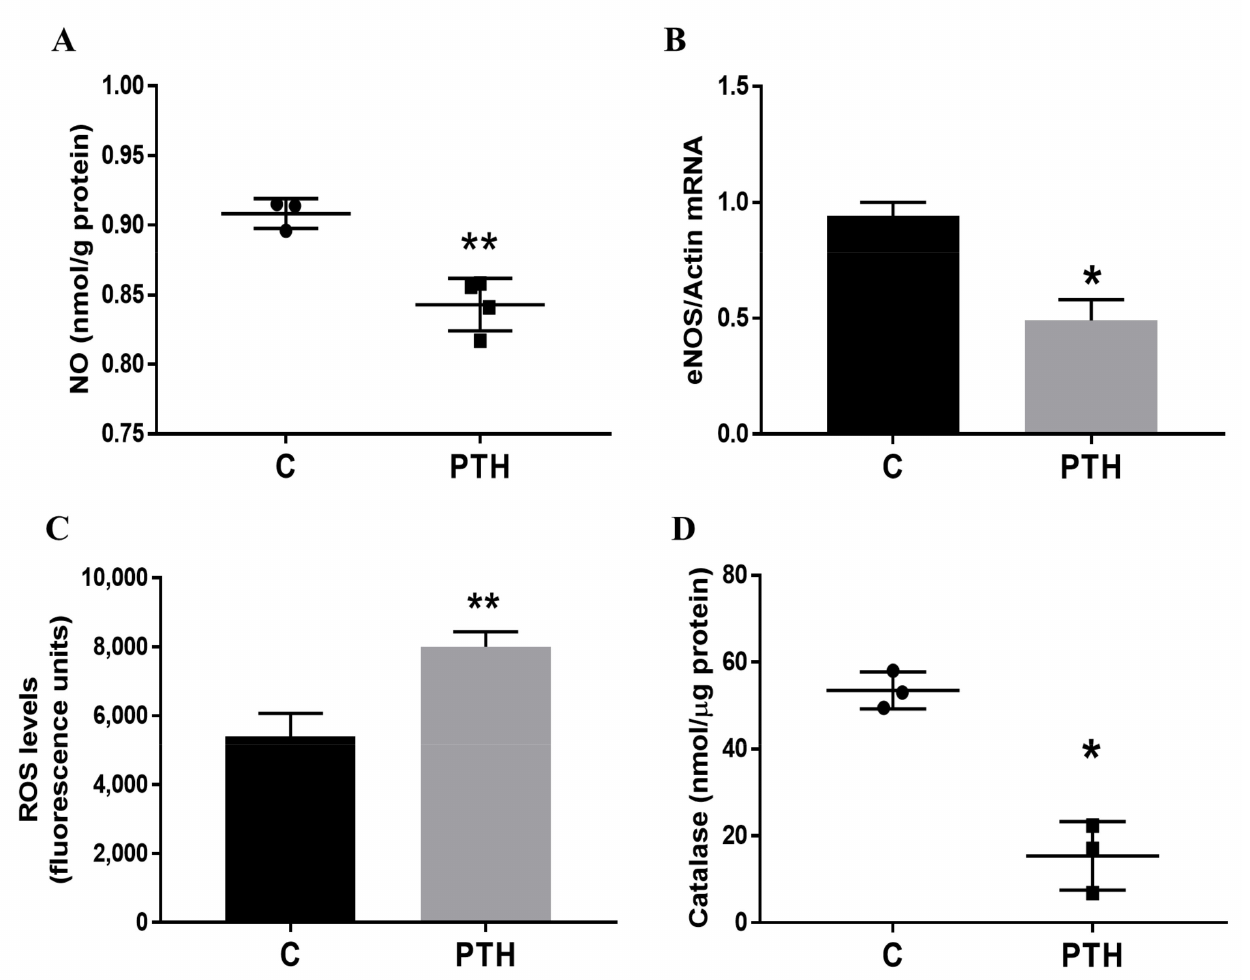
Figure 2. PTH induces VEC dysfunction, altering NO and ROS production, eNOS expression and catalase activity. ( A ) NO levels in VEC following exposure to PTH (10 − 9 M) for 7 days. ( B ) Gene expression of eNOS in control or PTH-exposed VEC. ( C ) Evaluation of ROS production in VEC, in response to PTH. The total amount of ROS was determined by incubating the cells with the fluorescent probe DCFDA. The ROS levels are expressed as relative fluorescence; ( D ) Catalase activity was determined at 570 nm and the values are expressed as nmol. Three independent experiments were performed * p < 0.05 and ** p < 0.01, PTH vs. the untreated control